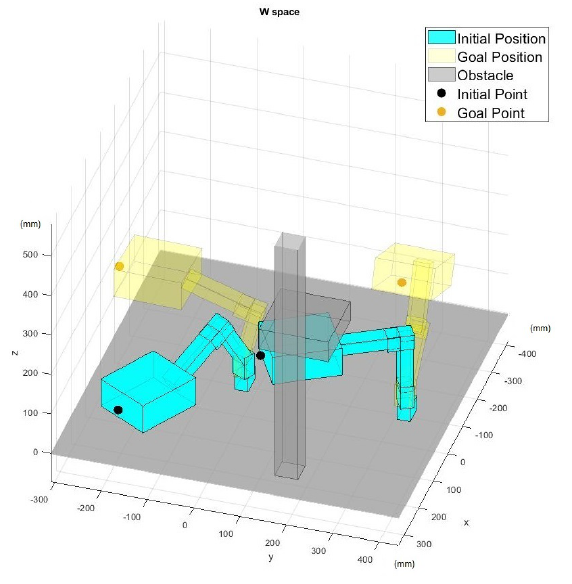
Figure 10. Initial and goal positions in the workspace.